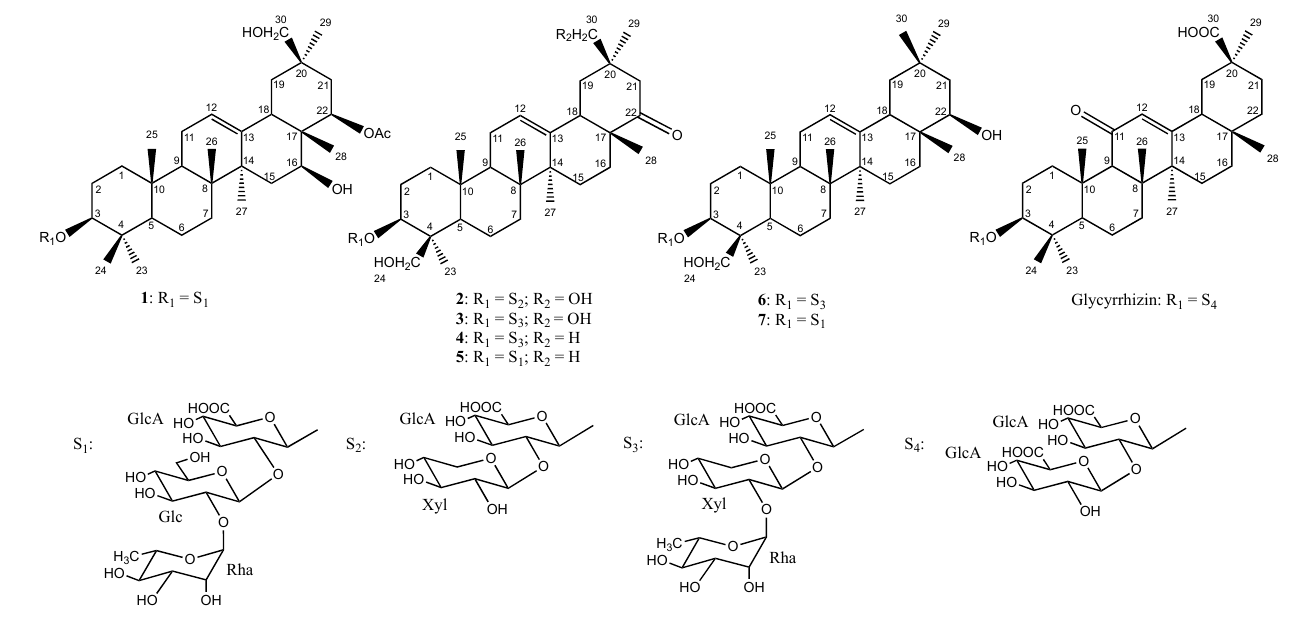
Figure 1. Structures of compounds 1 – 7 and glycyrrhizin.